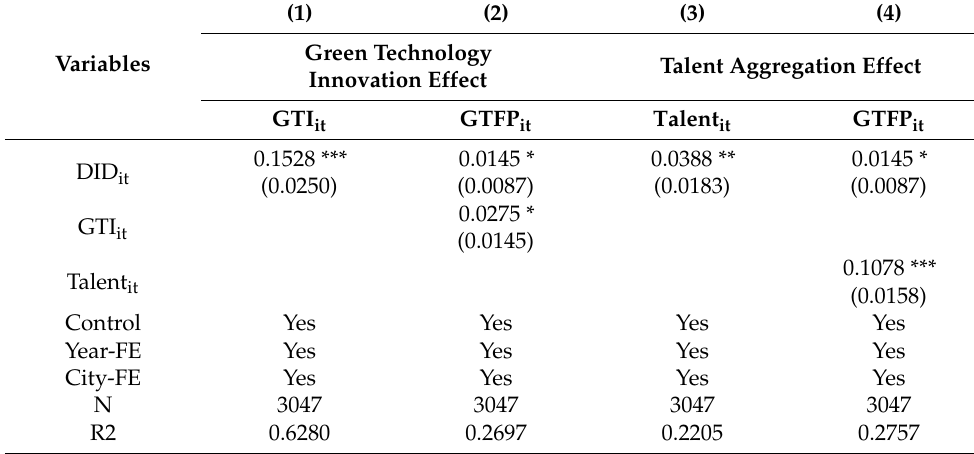
Table 6. Intermediary Effect